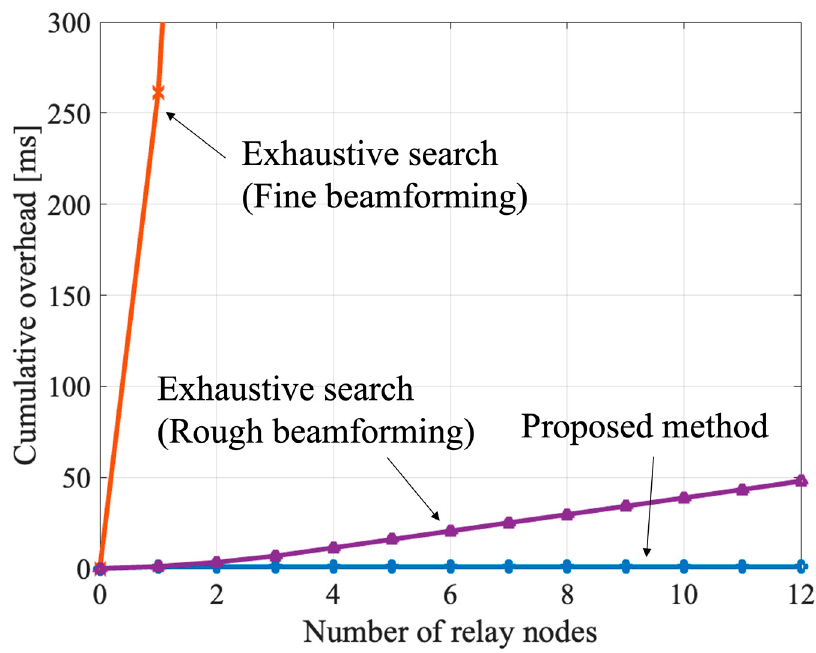
Figure 8. Cumulative overhead consumed to determine the relay beam on the RN access